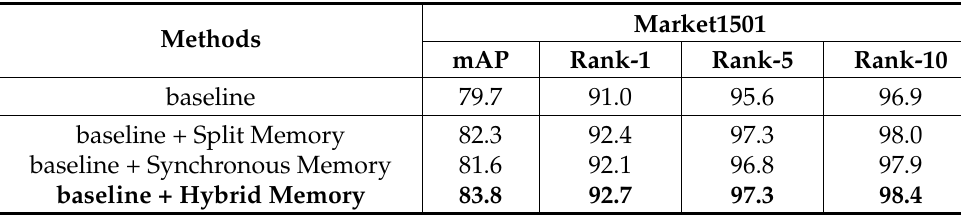
Table 7. Comparisons between our hybrid memory update mechanism and other memory update mechanism